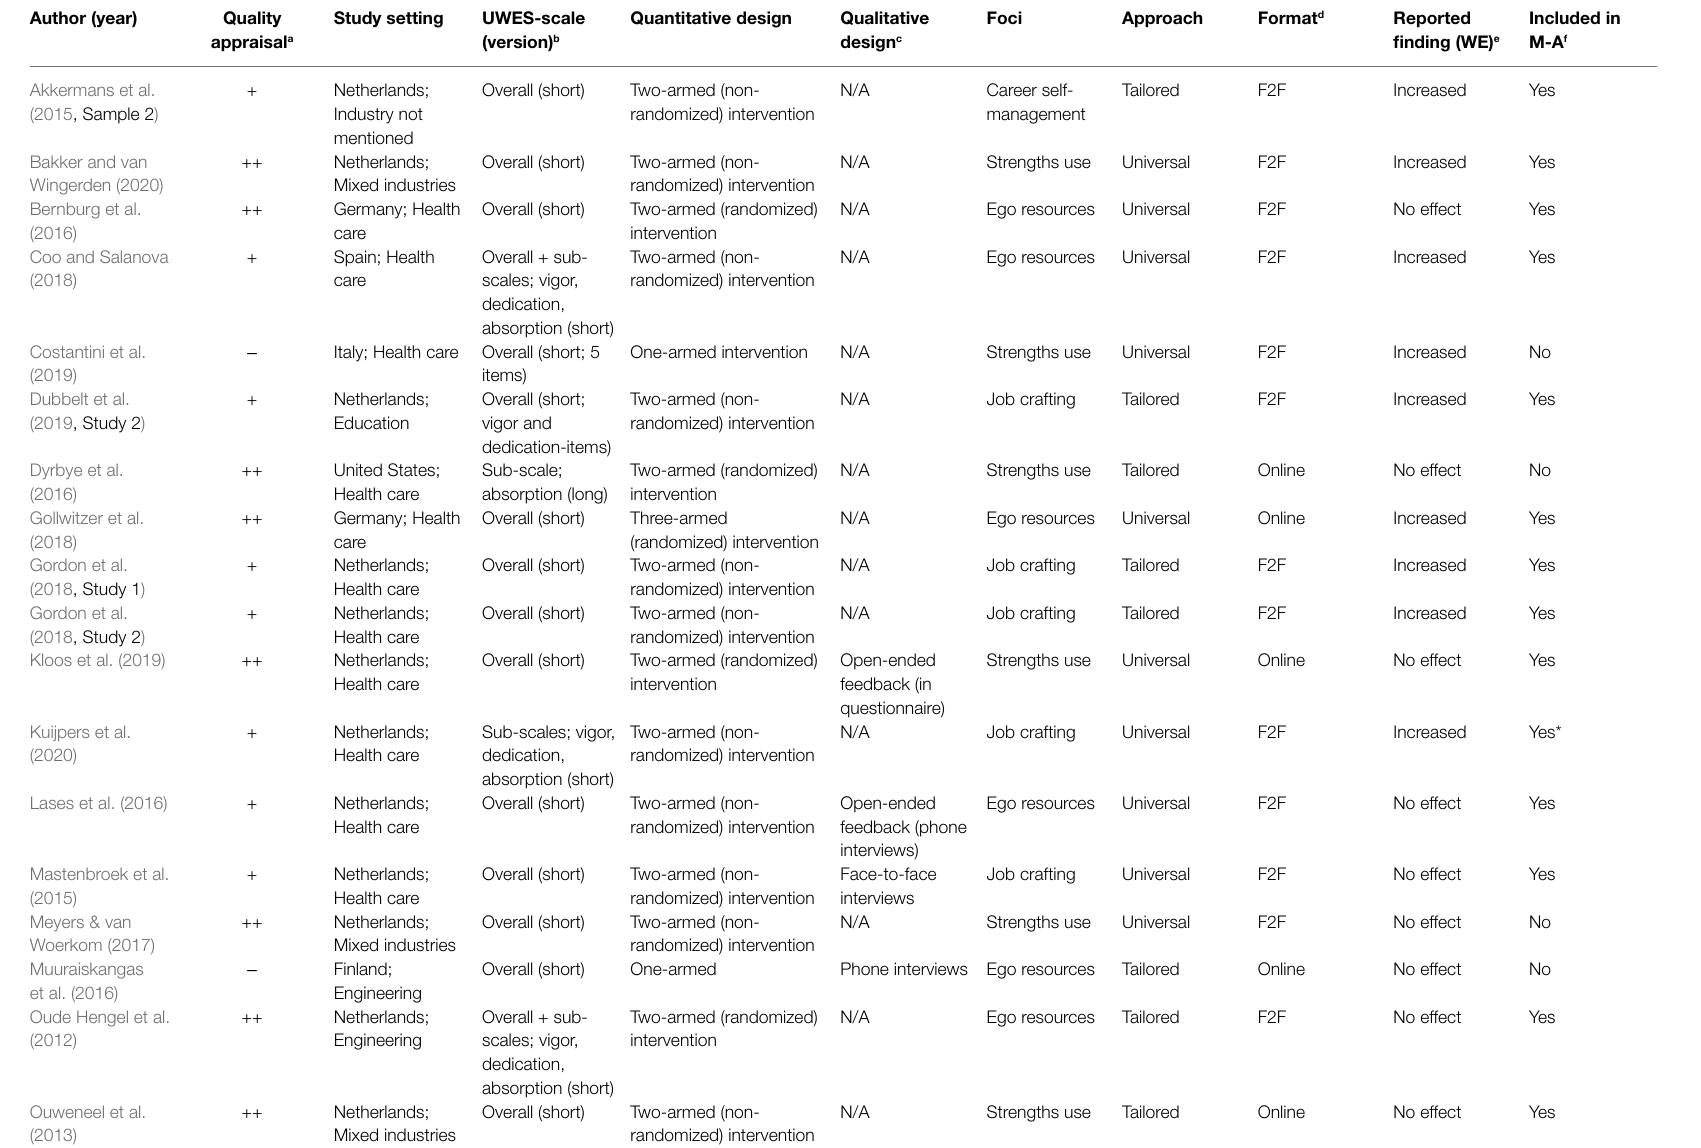
TABLE 1 | Summary of core characteristics and main findings of the included studies in the systematic review and